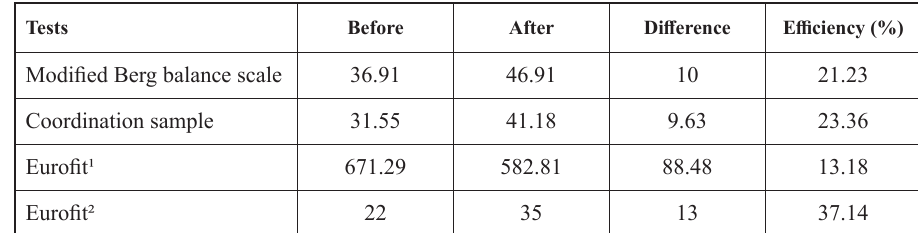
Table 3. The obtained test- ing results before and after PS program